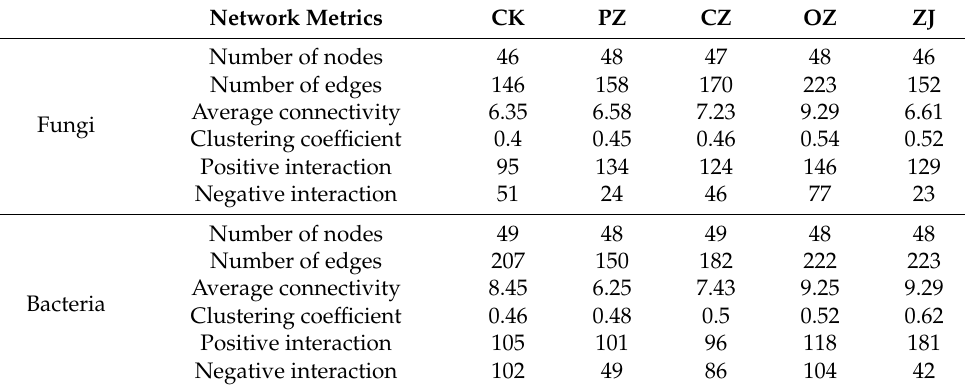
Table 1. Microbial network properties at four Corylus species.